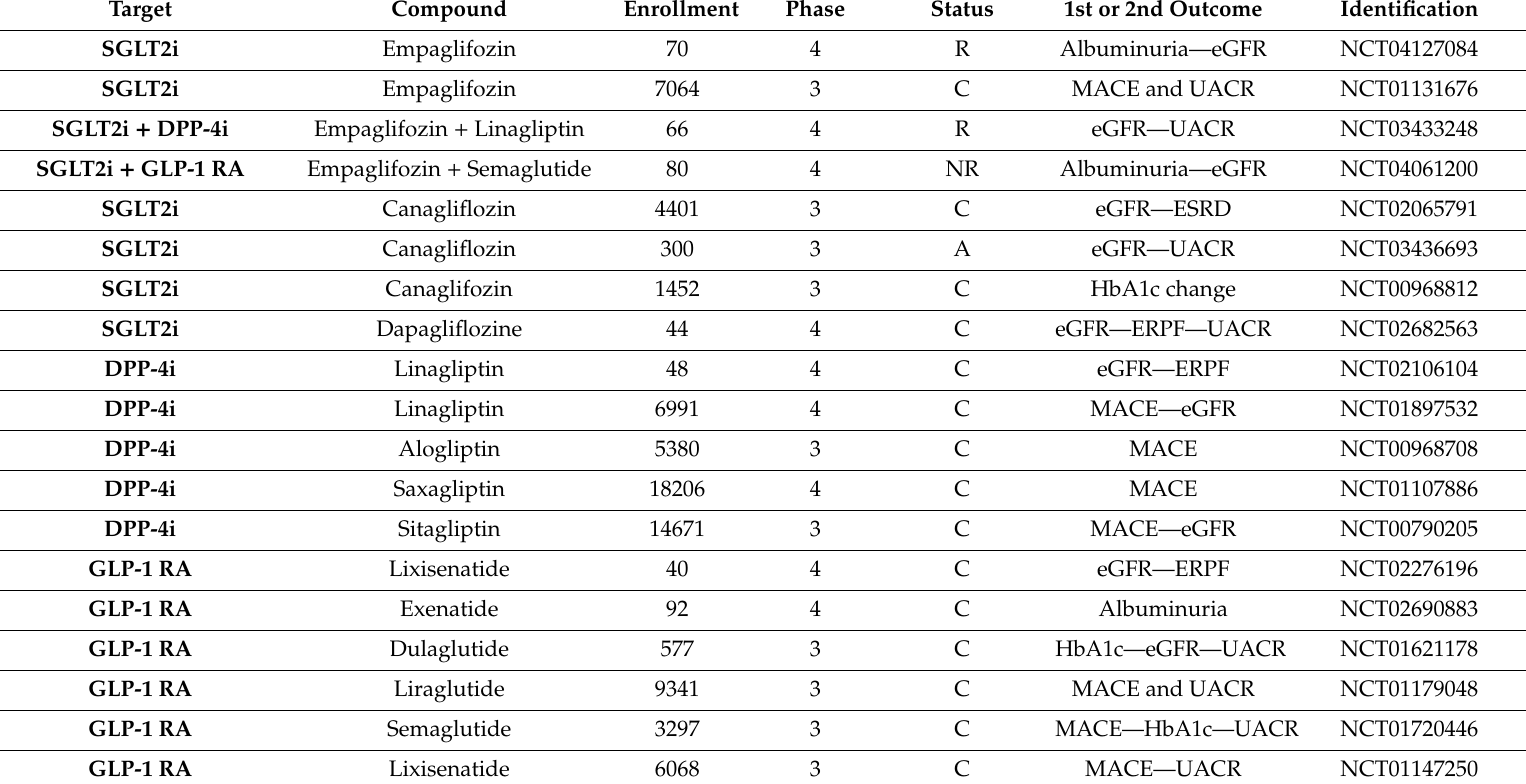
Table 4. Novel antidiabetic drugs with anti-inflammatory actions in patients with